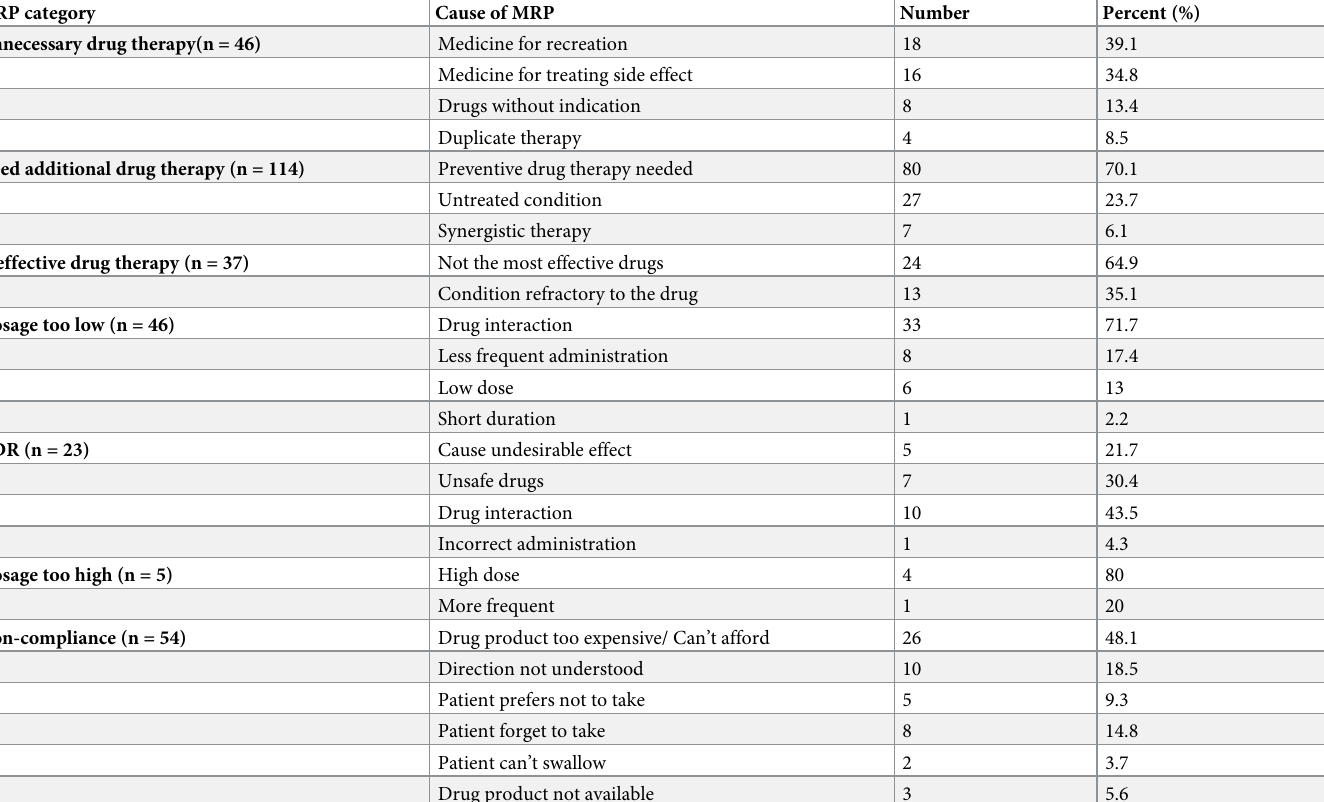
Table 4. Types of and causes of MRP identified among patients with CKD at St. Paul’s Hospital Millennium Medical College, Addis Ababa, Ethiopia, June-August, 2019. MRP category